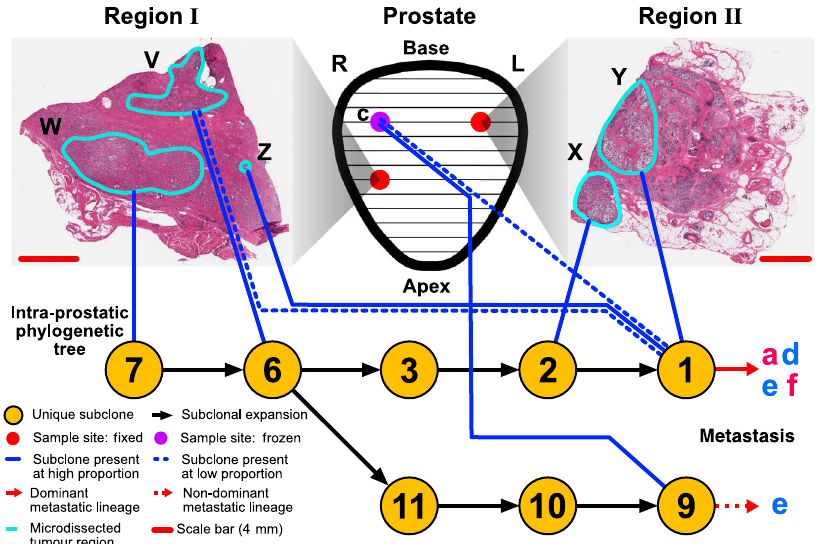
Fig. 5 Metastasis-capable cells in multiple sites within the prostate and perineural regions in A32. The prostate (center) was divided into 13 slices (black lines) and three regions were sampled, two from slice 10, and one from slice 6. The purple circle denotes the region that was fresh frozen and sequenced as sample c and the red circles denote regions that were ethanol/methanol fi xed and paraf fi n embedded. Histology slides shown to left and right, with microdissected regions highlighted in cyan with adjacent sequencing sample letters. The lower pane shows the phylogenetic tree of the intra- prostatic evolution, with numbers in the circles corresponding to subclonal clusters as derived in Supplementary Fig. 9. Lines joining the miscrodissected regions to a subclonal cluster indicate the fi nal subclone observed in each region; these are designated as high (CCF > 0.5) and low (CCF < 0.5)